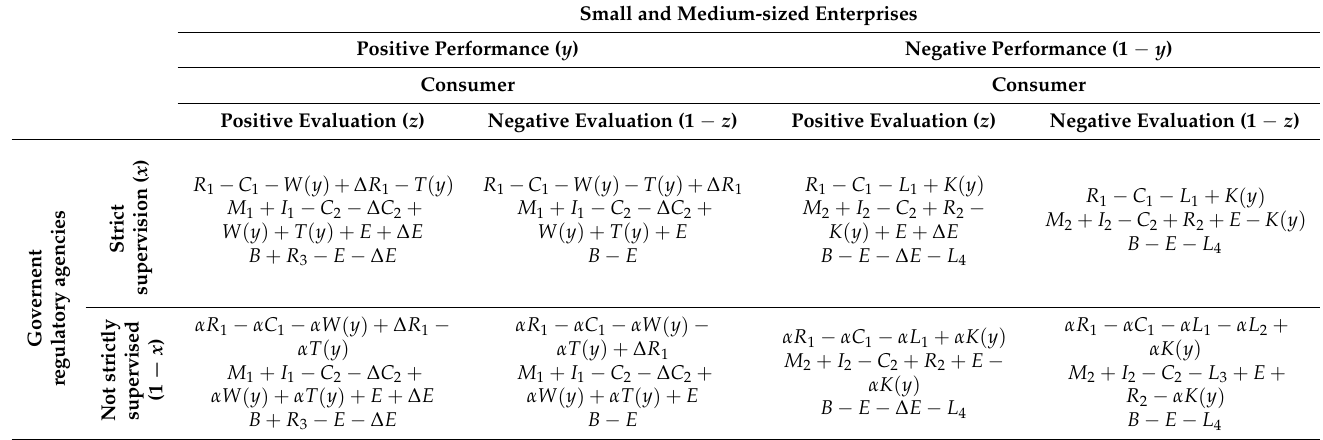
Table 4. Payment matrix of government regulatory agencies-SME-Consumer game stage after public health emergencies. Small and Medium-sized